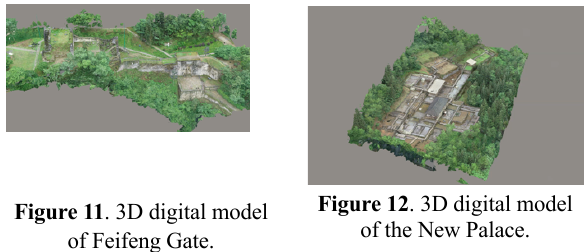
Figure 12 . 3D digital model of the New Palace.